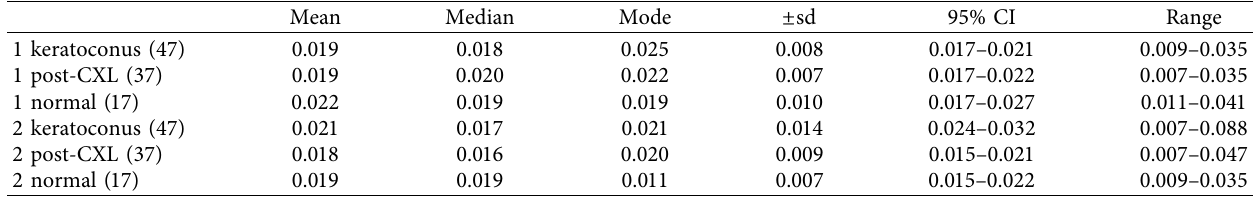
Table 2: Interoperator and intergroup differences in Ko estimations. 1 � Ko values estimated by operator 1. 2 � Ko values estimated by operator 2. Figures in parentheses are the number of individual cases where Ko values were not ≥ 0.11.